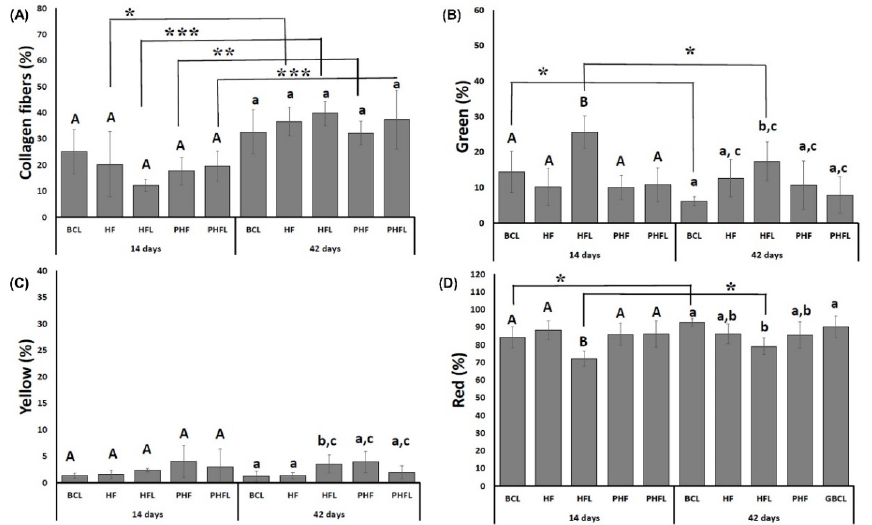
Figure 8. Graphs of the mean and standard deviation of the total percentage of birefringence of collagen fibers ( A ); green birefringence of collagen fibers ( B ); yellow birefringence of collagen fibers ( C ); red birefringence of collagen fibers ( D ). n = 12 group/period. Different uppercase (14 days, A ≠ B) and lowercase (42 days, a ≠ b ≠ c) letters, difference between groups/period (Kolmogorov– Smirnov normality test, unpaired Student “ t ” test). Asterisk (* or ** or ***) = significant difference between period/group; (one-way ANOVA and Tukey, p < 0.05).